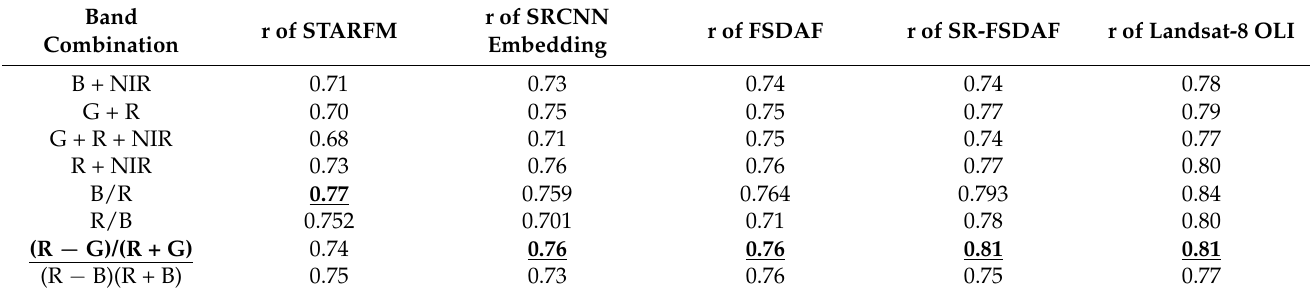
Table 6. Correlation values of different band combinations of fused image and Landsat-8 OLI.